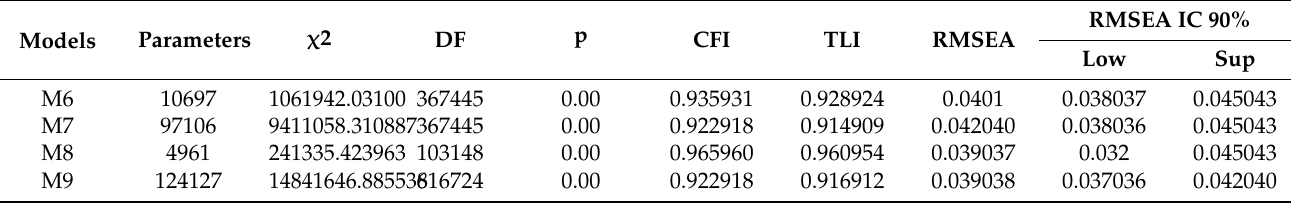
Table 3. Standardized indirect and total indirect effects of the mediation model.